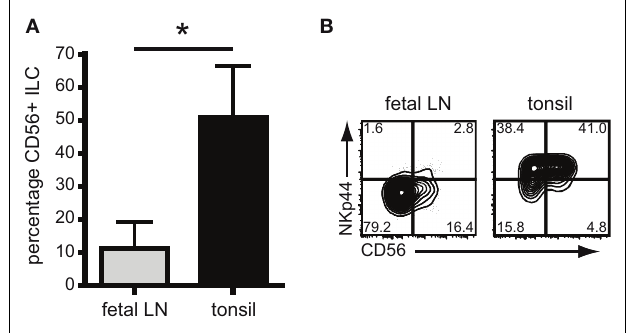
FIGURE 2 | CD56 expression on ILC from fetal LN and tonsil. (A) Percentage of CD56 expressing RORC + ILC in fetal lymph nodes and tonsil ( n > 5; Av ± SD, p = 0.007). (B) Flow cytometric analysis of CD56 and NKp44 expression on RORC + ILC in fetal lymph nodes and tonsil (representative example of five independent experiments).